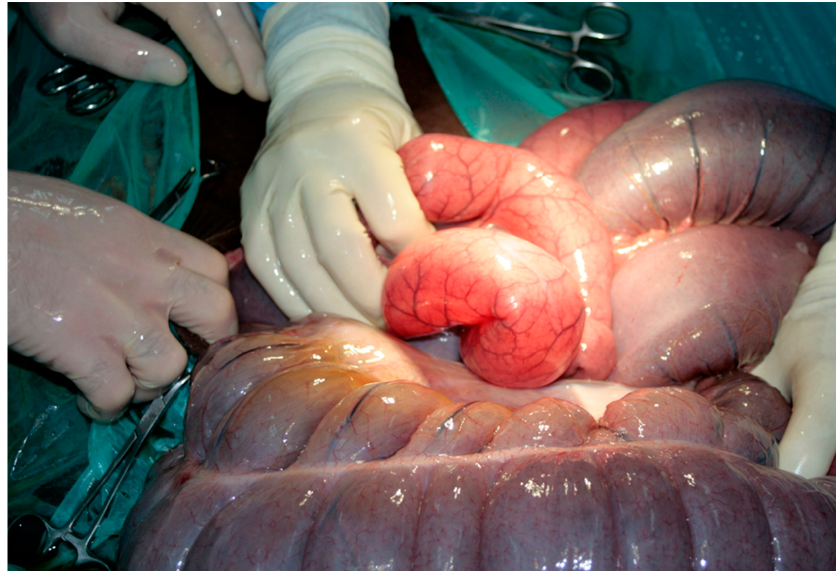
Figure 3. Bloated loops of the small intestines are visible in the mesenteric defect.